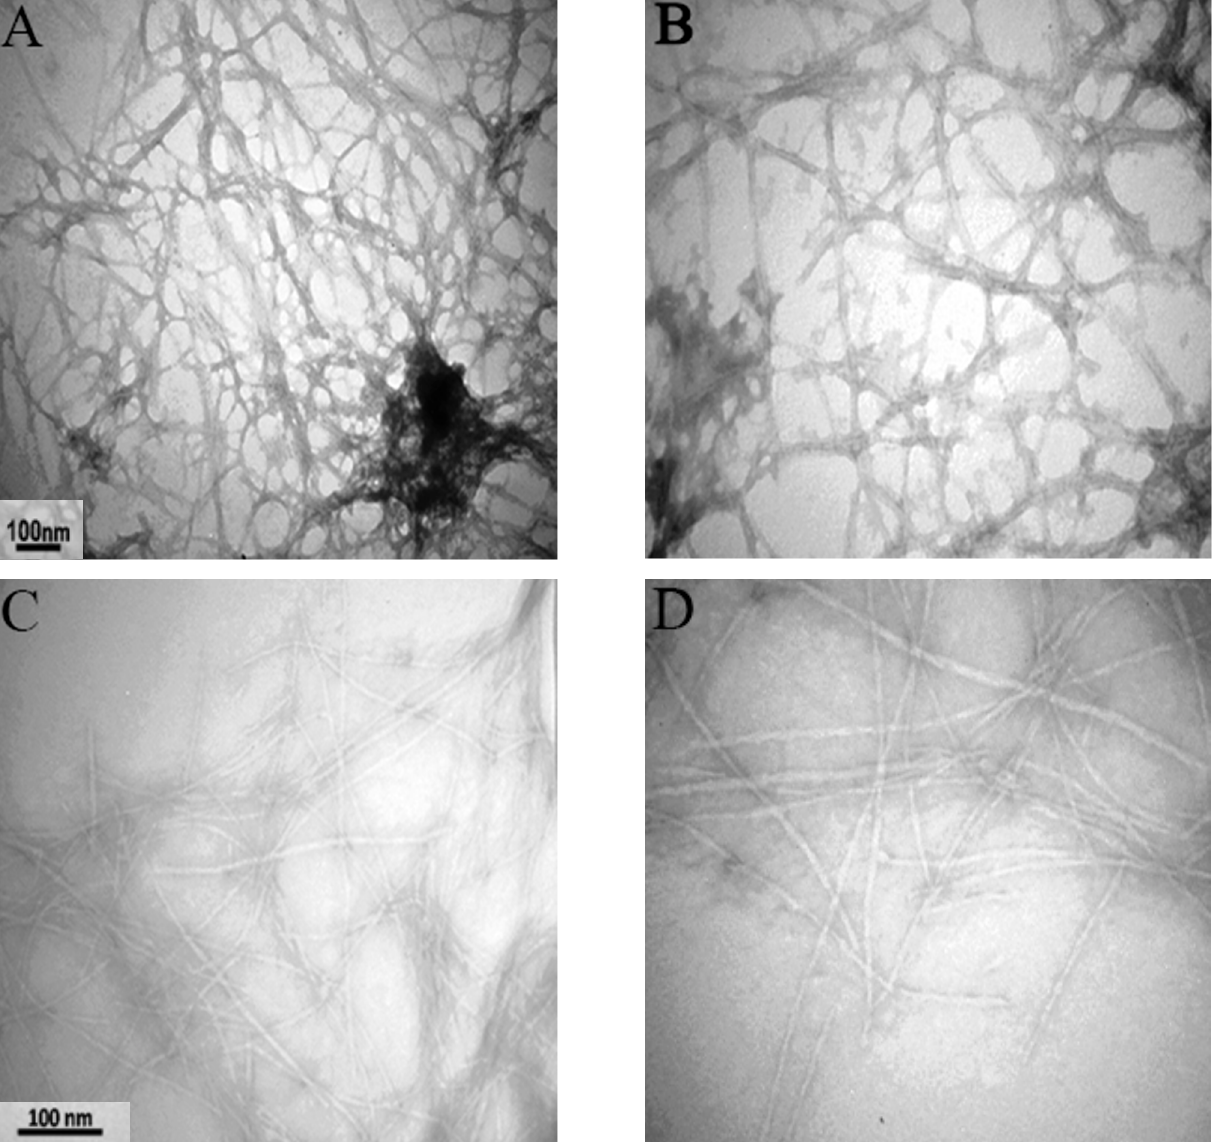
Figure 1. Transmission electron microscopy (TEM) image of regular insulin (1 mg/ml) incubated at pH 7.4 and 37 °C. The TEM image shows that amyloid fibril formed from regular insulin ( A , B ) and the effect of (0.5 mM) silymarin ( C , D ) on insulin amyloid